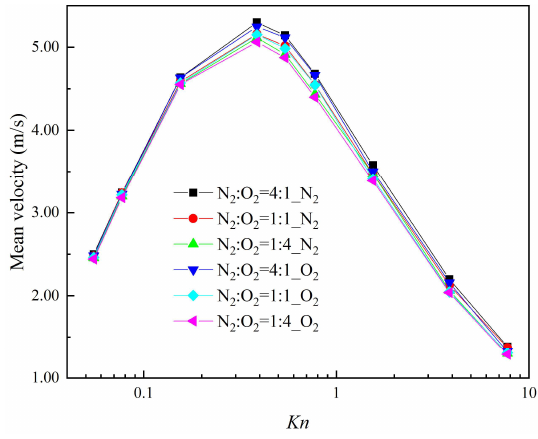
Figure 7. Mean velocities for different Knudsen numbers.